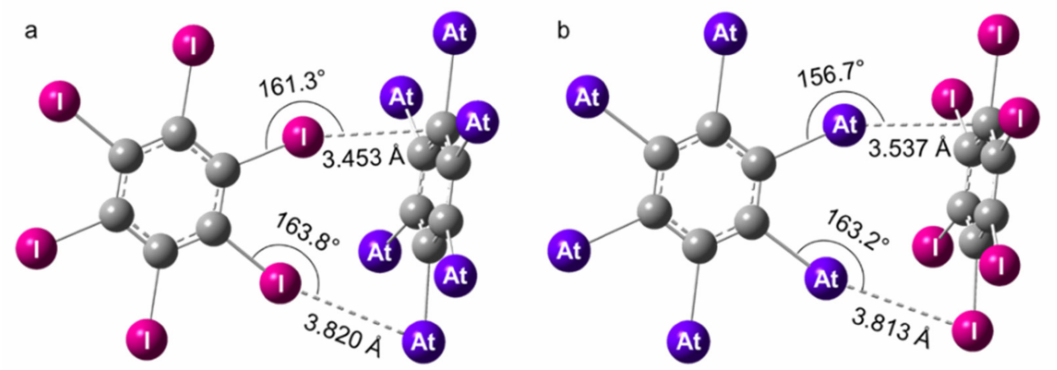
Figure 2. Structures of the XB complexes formed by C 6 At 6 and C 6 I 6 at the 2c-PW6B95-D3/TZVPPD level of theory. The XB interactions mediated by iodine (X = I, Y = At) are displayed on the left ( a ) and the ones mediated by astatine (X = At, Y = I) on the right ( b